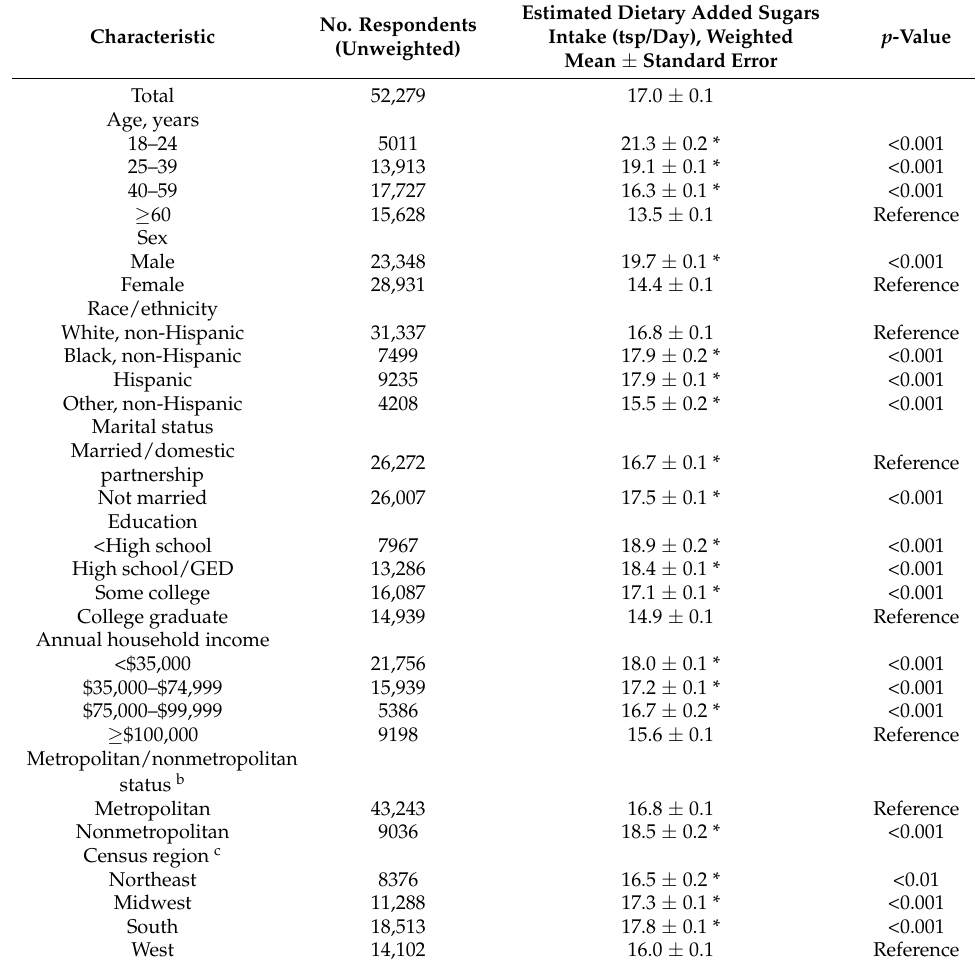
Table 1. Estimated mean dietary-added sugars intake (teaspoon/day) among US adults aged 18 or older (N = 52,279), United States, 2010 and 2015 a .